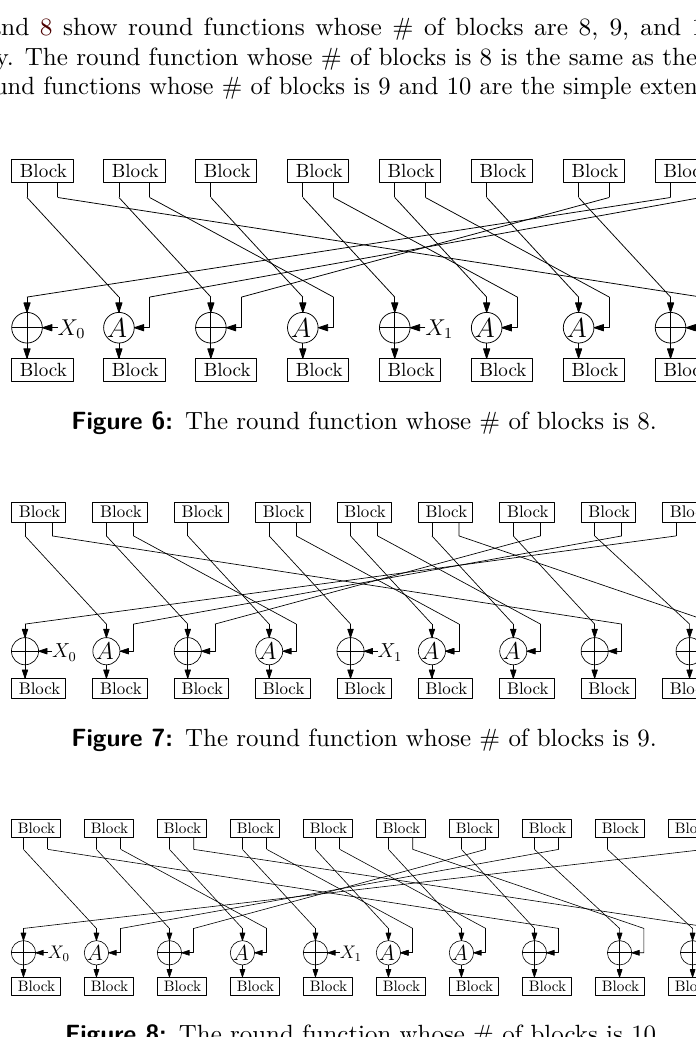
Figure 8: The round function whose # of blocks is